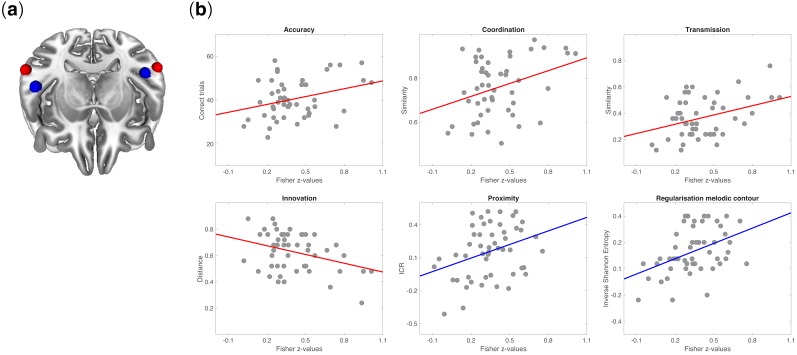
Neurobehavioral correlations.(a) Tilted axial view of regions activated by the auditory functional localizer task in the posterior STG (red spheres) and anterior STG (blue spheres). (b) Pearson’s product-moment correlations between rs-FC (among regions activated in the functional localizer) and measures of behavior in signaling games: coordination (r = 0.41; p=0.002), accuracy (r = 0.36; p=0.007), transmission (r = 0.41; p=0.002), innovation (r = −0.41; p=0.003), proximity (r = 0.35; p=0.01), and regularization of melodic contour (r = 0.43; p=0.001). All p-values were Bonferroni corrected at α = 0.05/7 = 0.007. Fisher’s z-transformed correlation coefficients were obtained between pairs of 5 mm ROIs from session one and measures of behavior (accuracy, coordination, transmission, innovation) or structural features of tone sequences (proximity, regularization of melodic contours) from the signaling games on session 2. Behavioral measures were defined as the extent to which the code learned by a participant in Game 1 (accuracy and coordination) was faithfully recalled and transmitted in Game 2 (transmission) and reorganized between Games 1–2 (innovation). Each point on a scatterplot is one participant (N = 51).